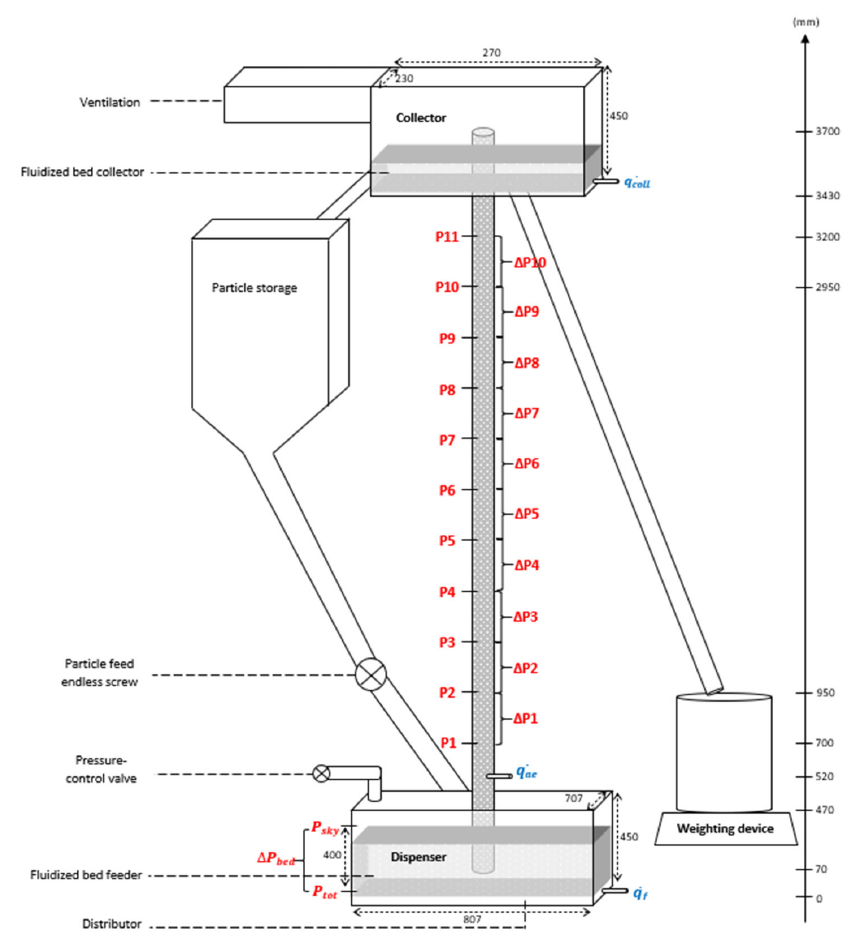
Figure 1. Schematic description of the cold mock ‐ up with instrumentation details.